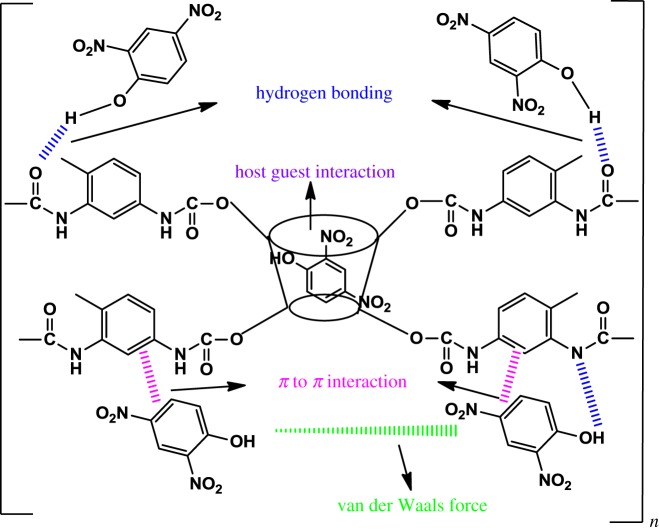
Proposed possible adsorption mechanisms for 2,4-DNP using βCD-TDI.